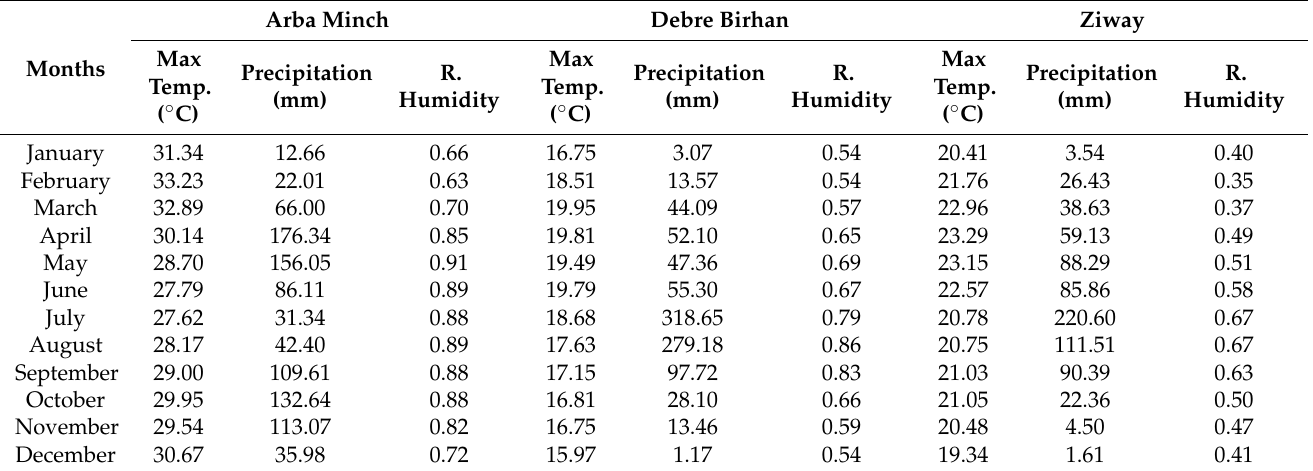
Table 1. Average monthly climate data of year